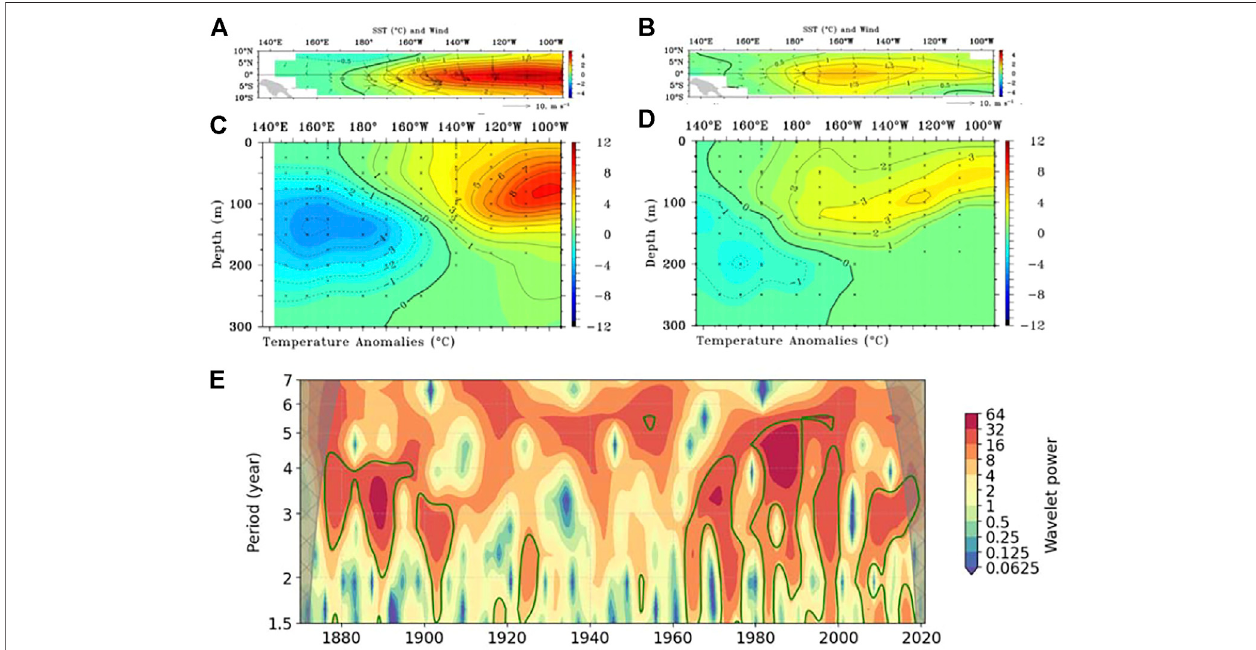
FIGURE1| November – December – January mean SSTanomalies (A,B) andsubsurfacetemperature anomalies at theequator (2 ° S-2 ° N) (C,D) during the1997/98 EP (A,C) and 2009/10 CP (B,D) El Niñoeventsfrom NOAA/PMEL (https://www.pmel.noaa.gov/tao/drupal/disdel/). (E) Waveletpower spectrumofthenormalizedtime seriesofNiño-3.4SSTanomaliesfromHadISST(Rayneretal.,2003).Thegreencontourenclosesregionsofgreaterthan95%con fi denceleveltestedagainstrednoise. Cross-hatched regions on either end indicate the “ cone of in fl uence ” where edge effects become